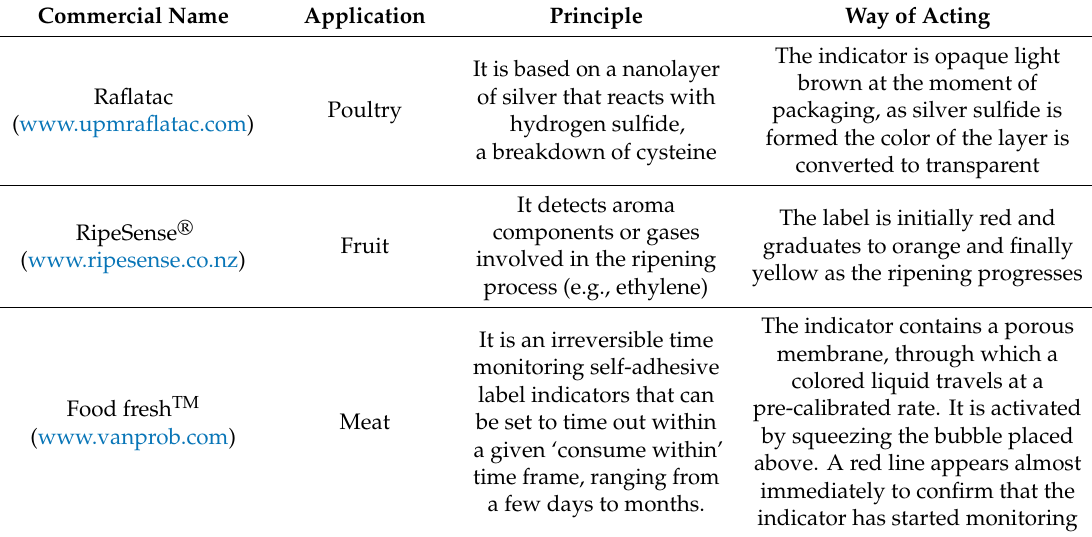
Table 5. Commercially available freshness